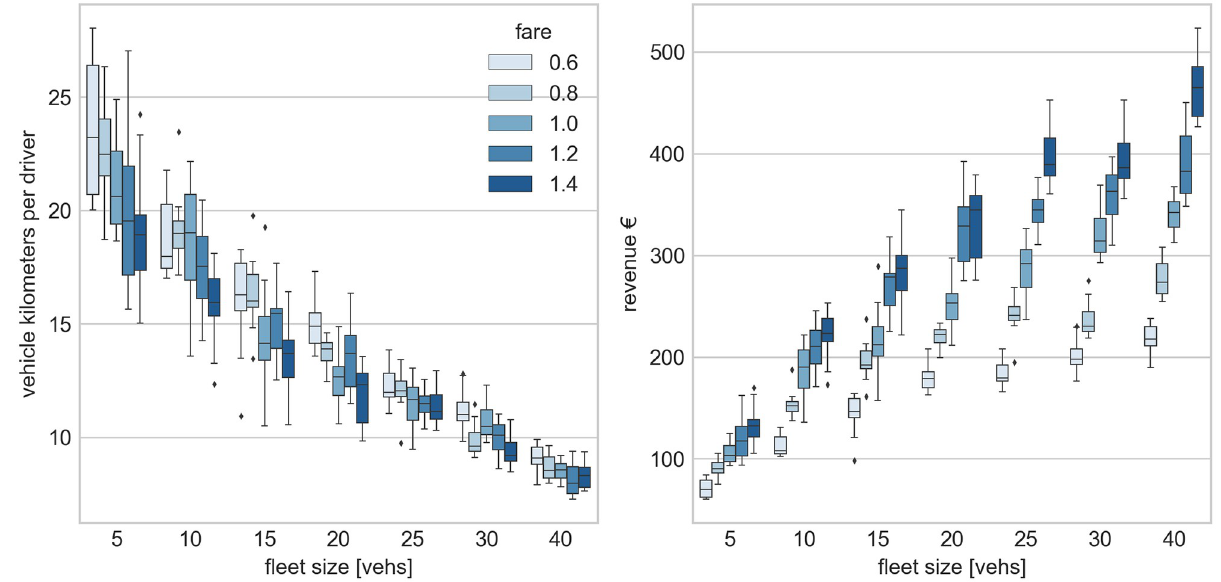
Fig 6. Searching for optimal platform competition strategy: A platform enters a market with a competitor operating a fleet of 20 vehicles and offering a trip fare of 1.0 unit/km. We report average vehicle kilometres per driver (left) and total platform revenues (right) resulting from varying fleet size (x-axis) and fare (per-kilometre) combinations for 20